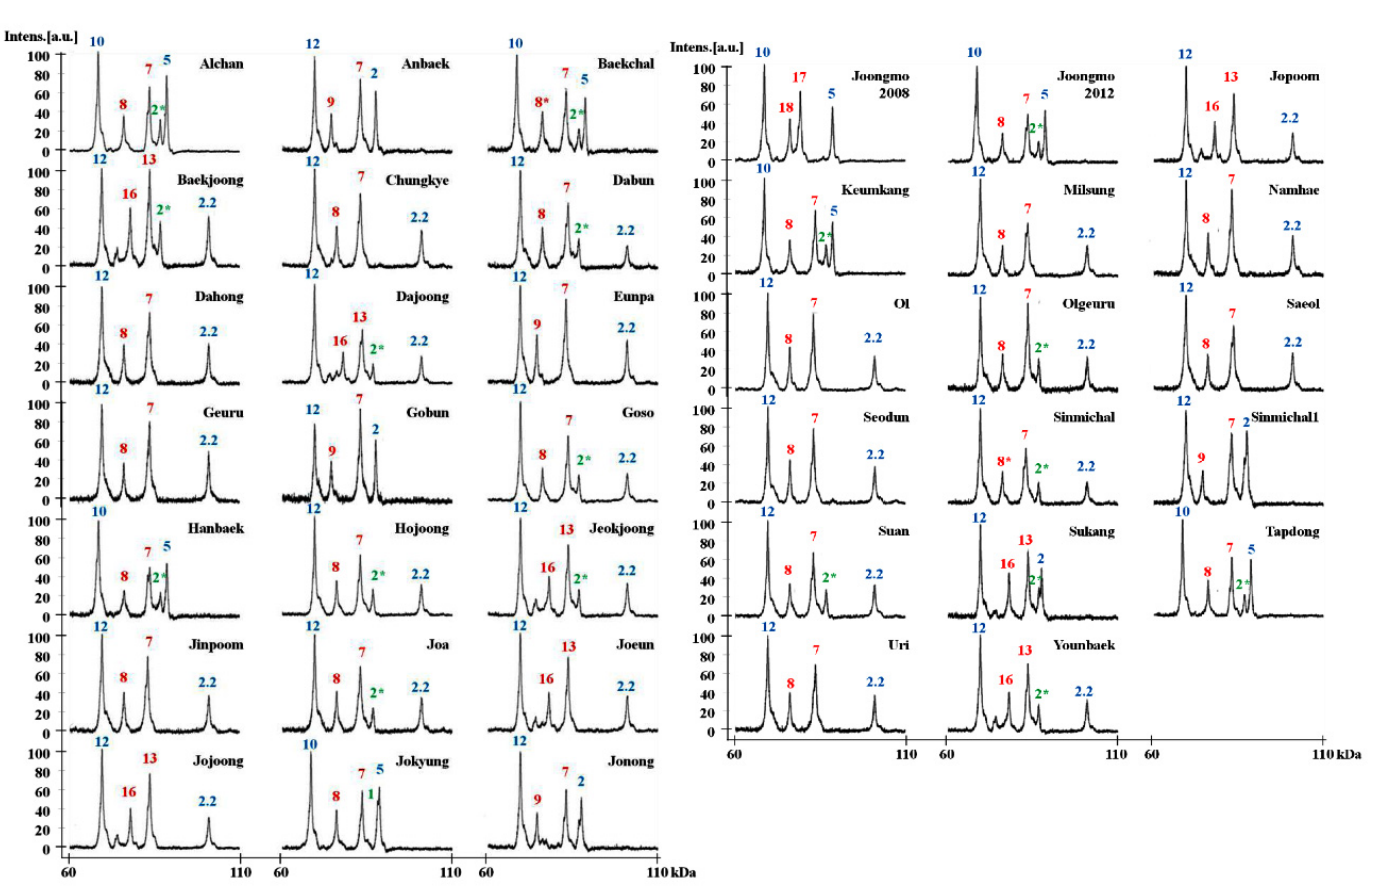
Figure 6. HMW-GS profiles of 38 Korean wheat cultivars of individual subunits determined by MALDI-TOF-MS. Subunits corresponding to chromosomes 1A, 1B, and 1D are shown in green, red, and blue, respectively.